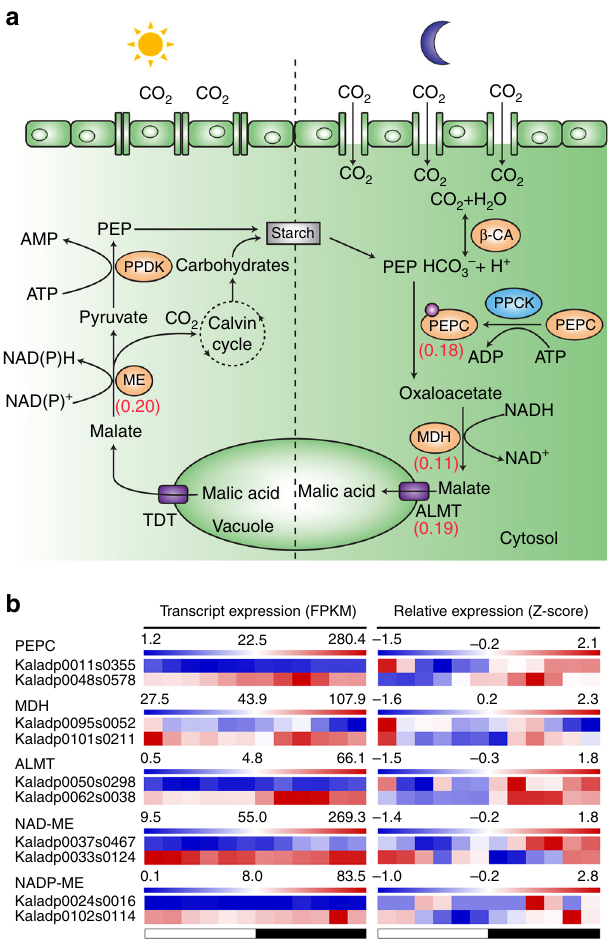
Fig. 3 An overview of CAM pathway in Kalanchoë fedtschenkoi . a The CAM pathway map in K. fedtschenkoi . Orange colors indicate the key enzymes involved in the CAM pathway. The numbers in parenthesis are the four-fold transversion substitution rate (4dtv) values. b Diel expression pro fi les of duplicated genes in CAM-related gene families. ALMT tonoplast aluminum-activated malate transporter, β -CA β type carbonic anhydrase, ME malic enzyme, MDH malate dehydrogenase, PEP phosphoenolpyruvate, PEPC PEP carboxylase, PPCK PEPC kinase, PPDK pyruvate phosphate dikinase, TDT tonoplast dicarboxylate transporter. White and black bars indicate daytime (12-h) and nighttime (12-h),